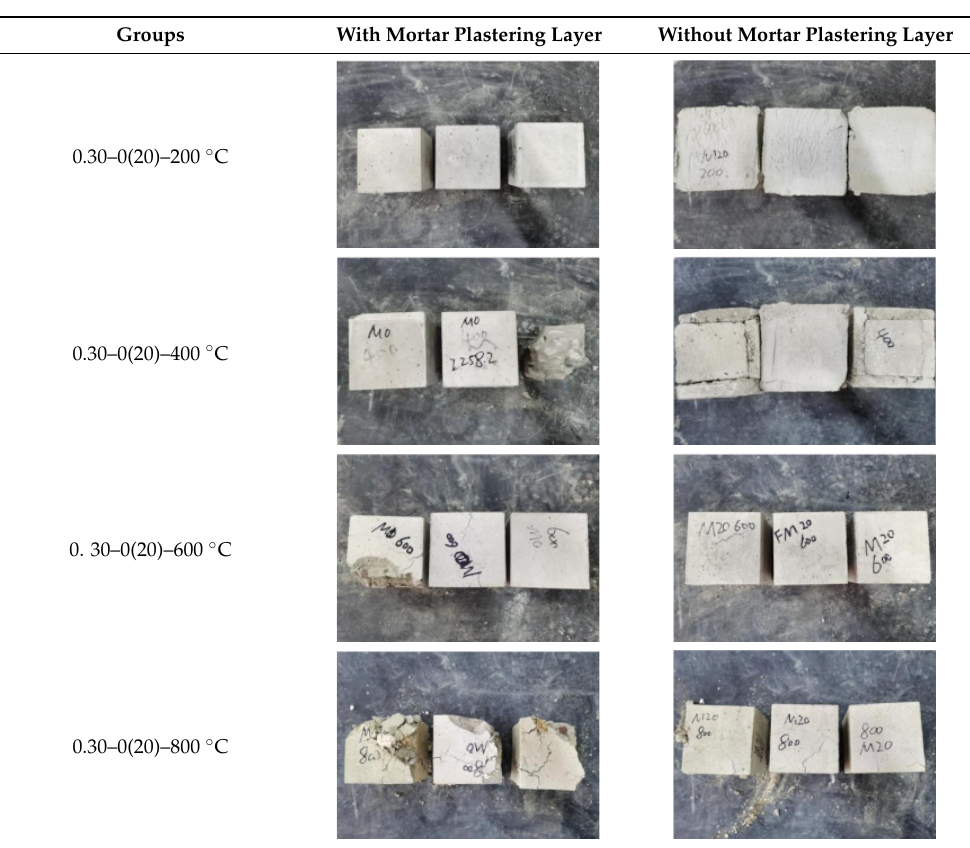
Table 5. Appearance of concrete specimens after high temperature resistance